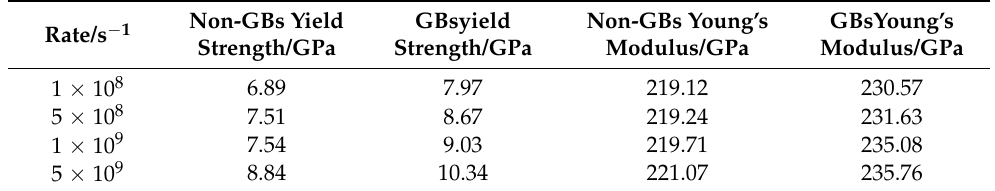
Table 1. Young’s modulus and yield strength of GBs HEAs and non-GBs HEAs at different strain rates.